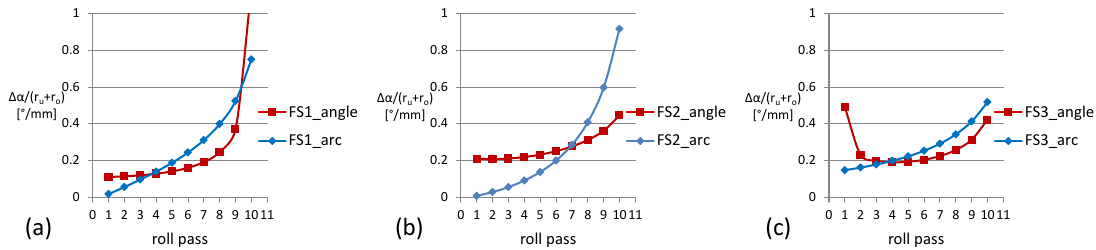
Figure 19. Effect of adapting the bending radii to ensure constant bending arc length on ∆α/(r u + r o ).